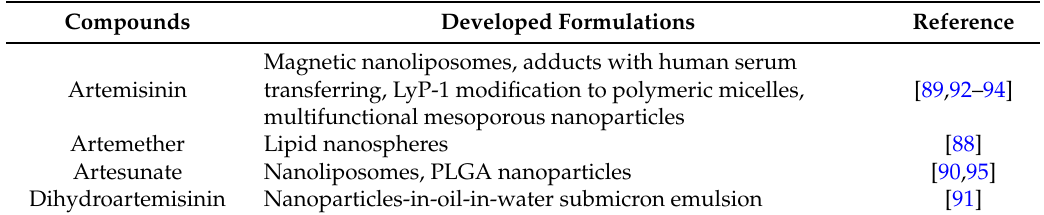
Table 2. Developed nanodrug delivery system for artemisinin and its derivatives